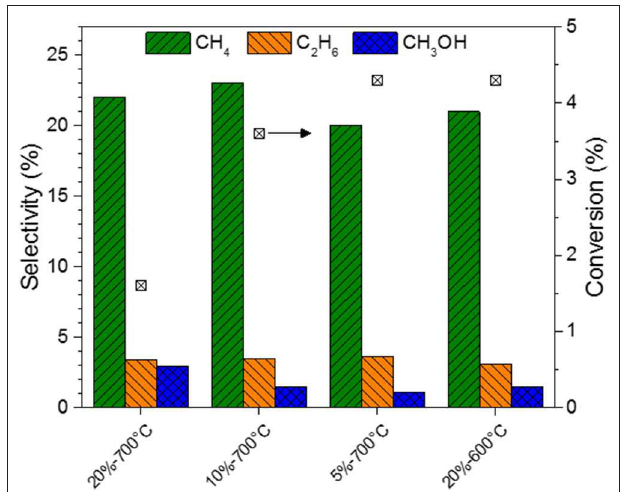
FIGURE 7 | Selectivity to methane, ethane, and methanol, and conversion for MoC/TiO 2 -P as a function of the carburizing ethane concentration (5, 10, or 20% in H 2 ), and the carburization temperature (600 or 700 ◦ C). Catalytic